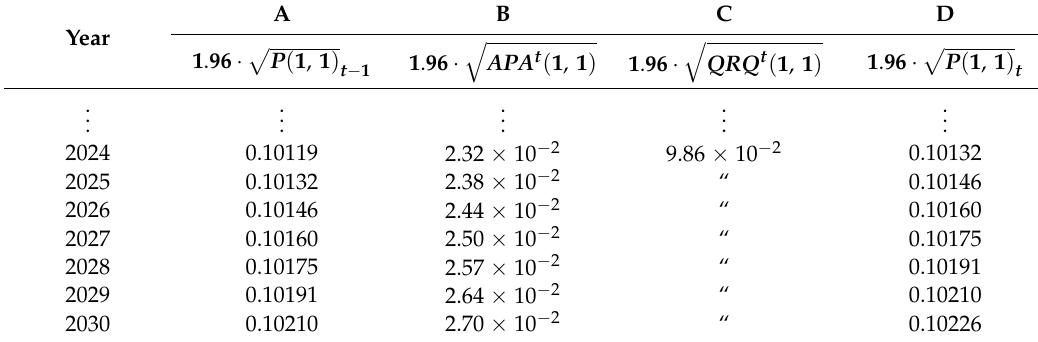
Table 6. Steady state behavior of ln(C res ) variance and its components, as from Equation